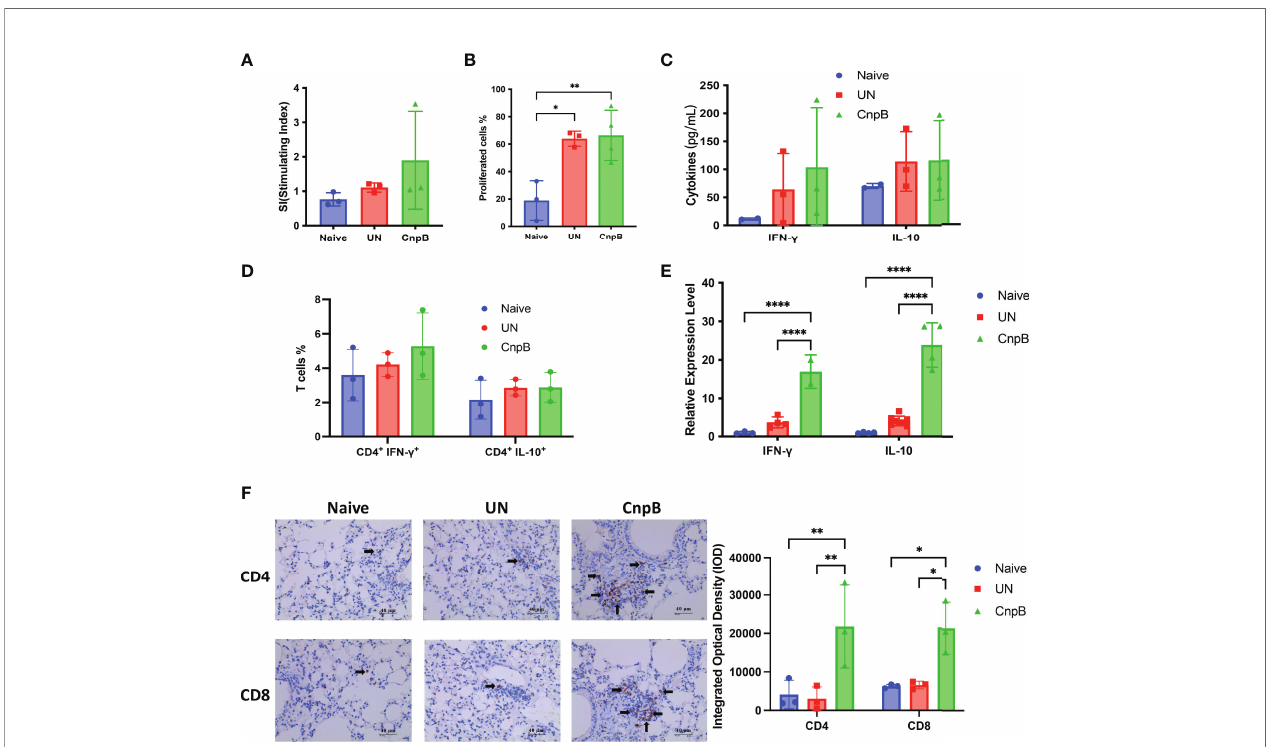
FIGURE 6 | Cellular immune responses of CnpB-immunized mice after M. tuberculosis intranasal infection. After M. tuberculosis H37Ra intranasal challenge for 8 weeks, cellular immune responses were determined as follows. (A) Proliferation of splenocytes measured by MTS reagent ( n =3). (B) Splenocytes were labeled with CFSE reagent, and then stimulated with 5 m g/mL CnpB proteins. Proportion of proliferated cells was assayed by fl ow cytometry ( n = 3 or 4). (C) Levels of cytokines IFN- g and IL-10 secreted by splenocytes were detected using ELISA ( n = 2 or 3). (D) Splenocytes were stimulated by 5 m g/mL CnpB proteins, and percentages of CD4 + T cells producing IFN- g and IL-10 were determined by fl ow cytometry ( n =3). (E) Transcriptional levels of IFN- g and IL-10 cytokines in the lungs were detected using qRT-PCR ( n ranges from 2 to 8). (F) Immunohistochemical observation and integrated optical density of CD4 + and CD8 + T cells in lung tissues of CnpB- immunized mice infected with H37Ra intranasally ( n =3). The arrows represented the stained CD4 + and CD8 + T cells. The results are expressed as mean ± SD. * P < 0.05, ** P < 0.01, **** P <